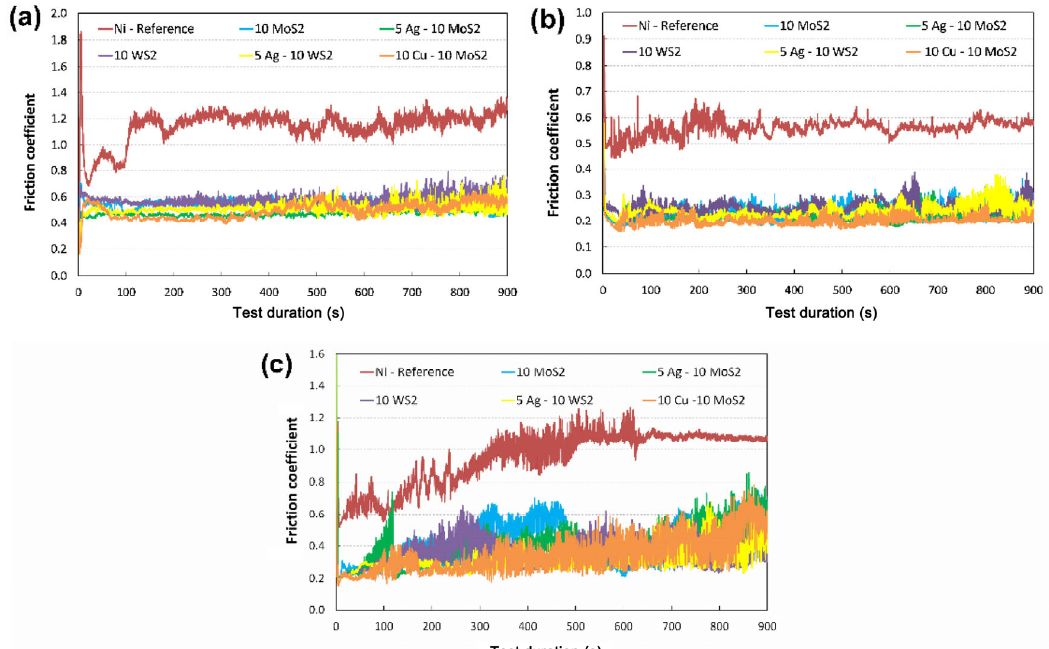
Fig. 26 Friction during reciprocating tests for the Ni-based claddings against AISI 52100 flat pins at (a) RT, (b) 400 ° C, and (c) 600 ° C. Reproduced with permission from Ref. [556]. © Elsevier,